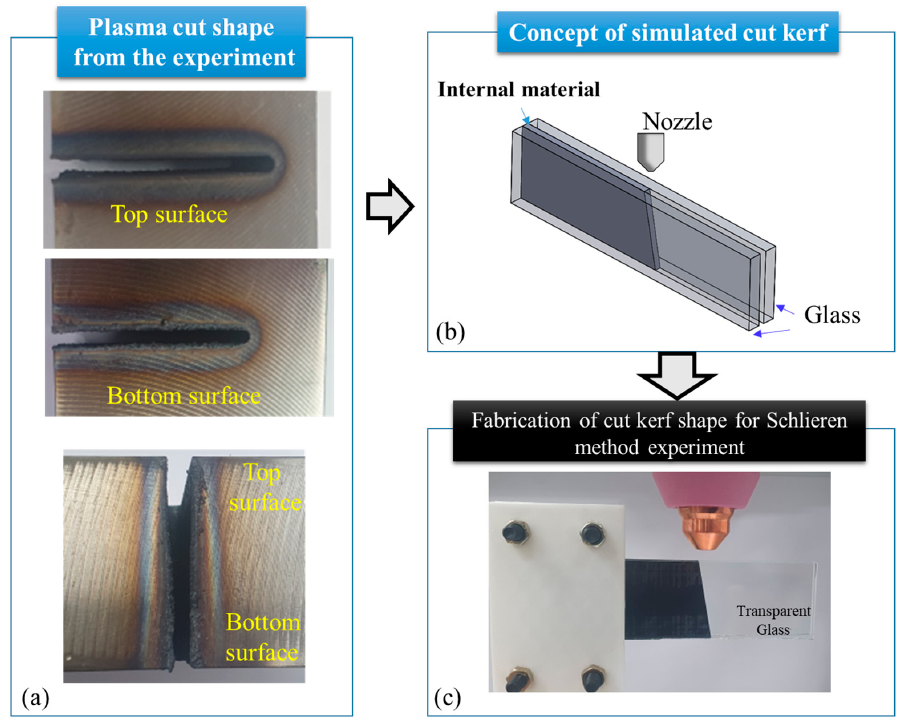
Figure 2. Process of fabricating cut kerf shape assembly for Schlieren experiment. ( a ) Plasma cut sample; ( b ) kerf geometry design for Schlieren experiment; ( c ) fabricated kerf assembly for Schlieren experiment.